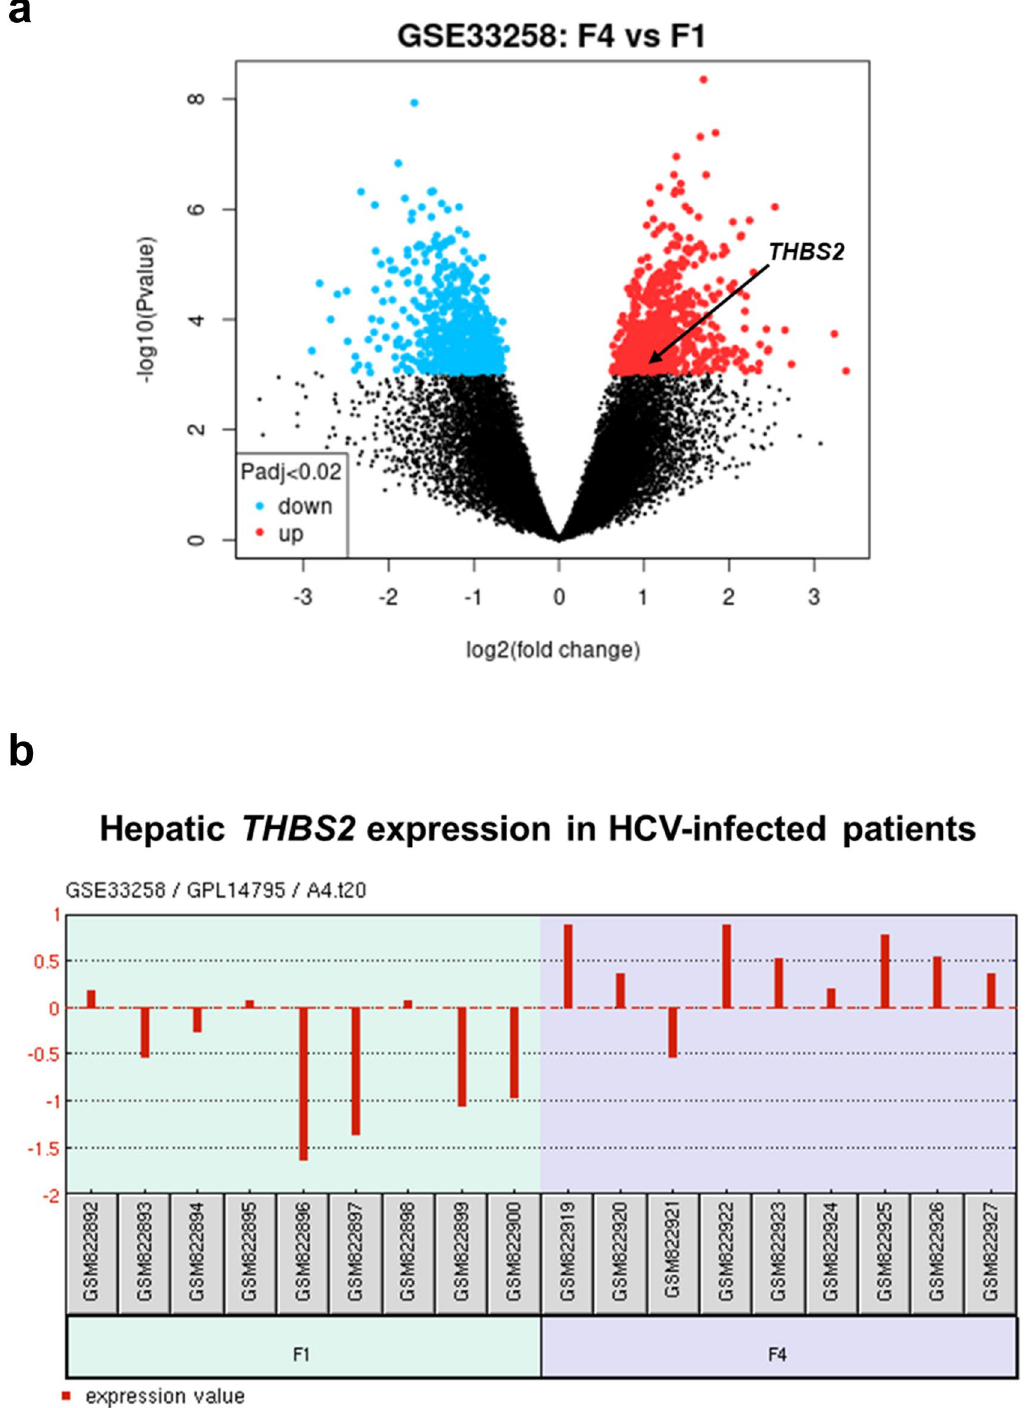
Figure 3. Liver mRNA data analysis of HCV-infected patients using GSE33258. ( a ) Volcano plot extracted from GSE33258. This plot visualizes differentially expressed genes by displaying statistical significance (− log10 P value) and magnitude of change (log2FC). Genes are significantly differentially expressed with a P value cut-off of 0.02 (red = up-regulated, blue = down-regulated). Arrows indicate THBS2 , the gene responsible for TSP2. ( b ) THBS2 expression profiles for each case included in GSE33258. F fibrosis stage, HCV hepatitis C